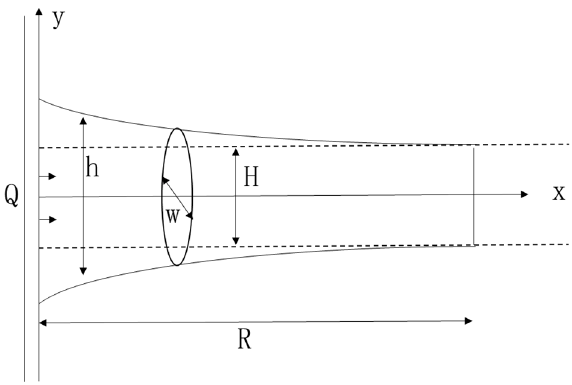
Figure 1. Quasi-three-dimensional fracture geometry.